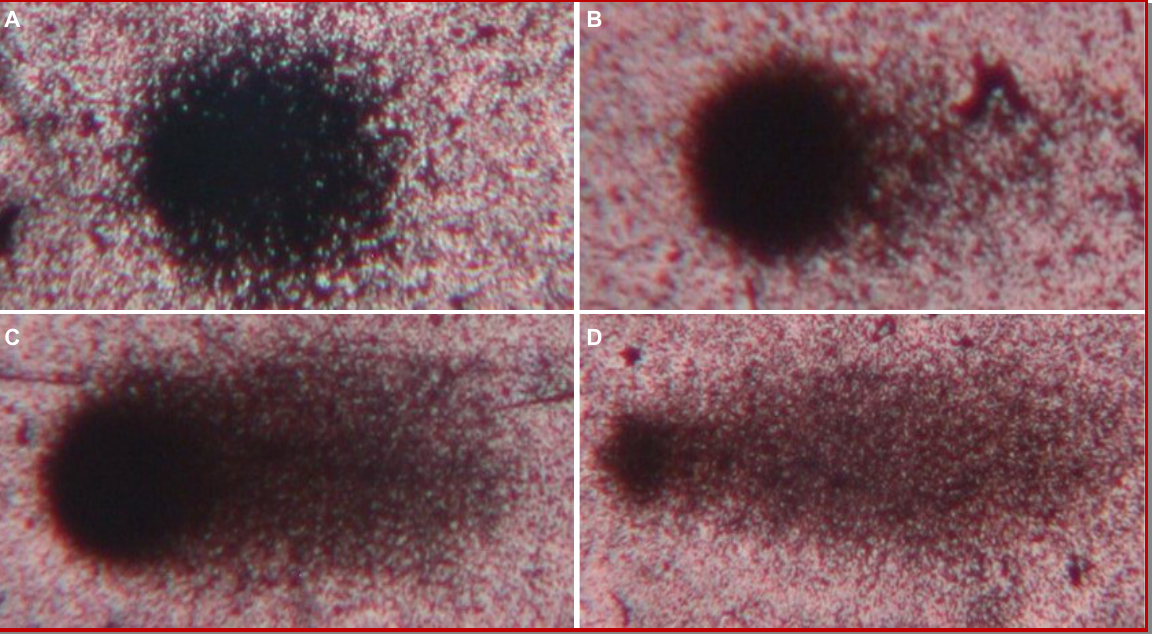
Figure 1: Comet images of blood cells from lead-treated rat. Following consecutive 5 days treatment with 0 (A), 25 (B), 50 (C) and 100 (D) mg/kg lead, the extent of DNA damage was assessed by comet assay coupled with silver staining. Treatment with lead increases the DNA damage in a dose-dependent